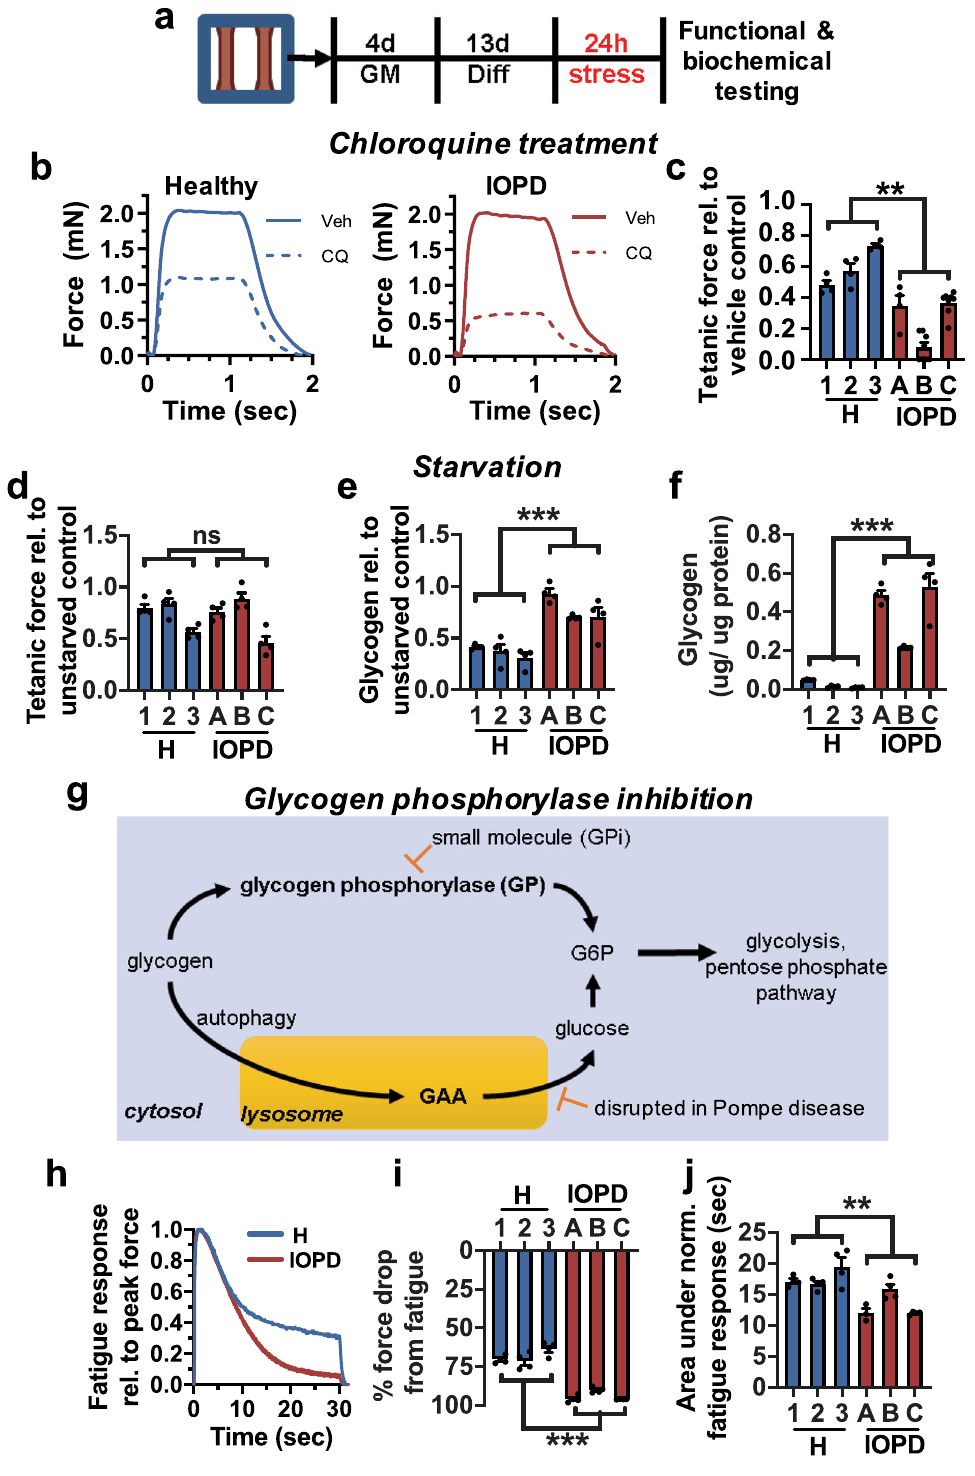
enrichment analysis (GSEA) using the gene ontology (GO) annotation to investigate the signi fi cant functional categories describing coordinated gene expression revealed both expected and novel descriptors of Pompe disease ( q < 10 − 3 ), including